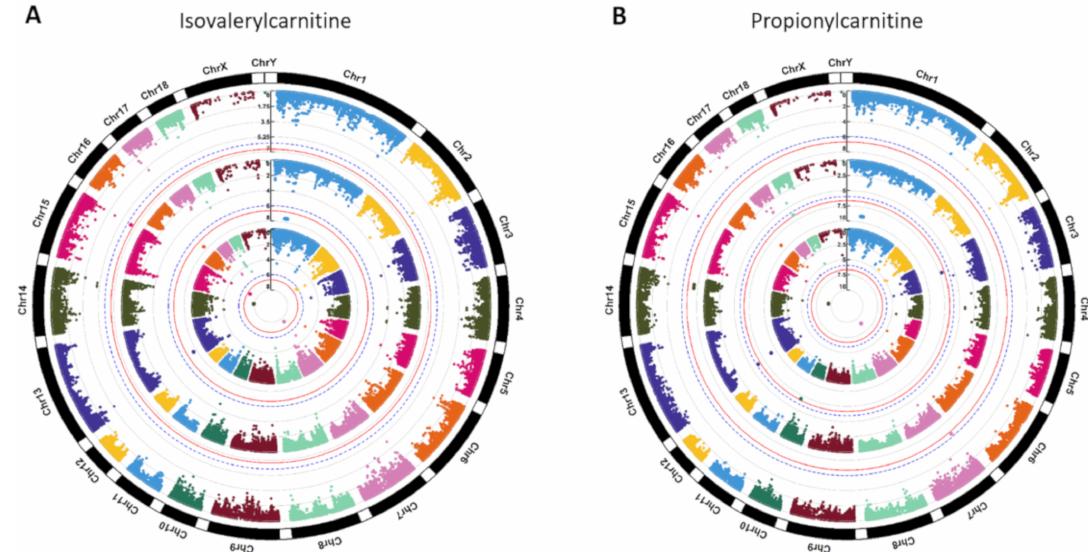
Figure 2. Manhattanplotsofgenome-wideassociationfor( A )isovalerylcarnitineand( B )propionylcarnitine. Note: Y -axis indicates the log 10 ( p -value). Blue dotted and red solid lines indicate the genome-wide threshold of 0.05 and 0.01 after Bonferroni multiple testing, respectively. The three tracks indicate the metabolites from first sampling time, second sampling time, and combined two sampling times from outside to